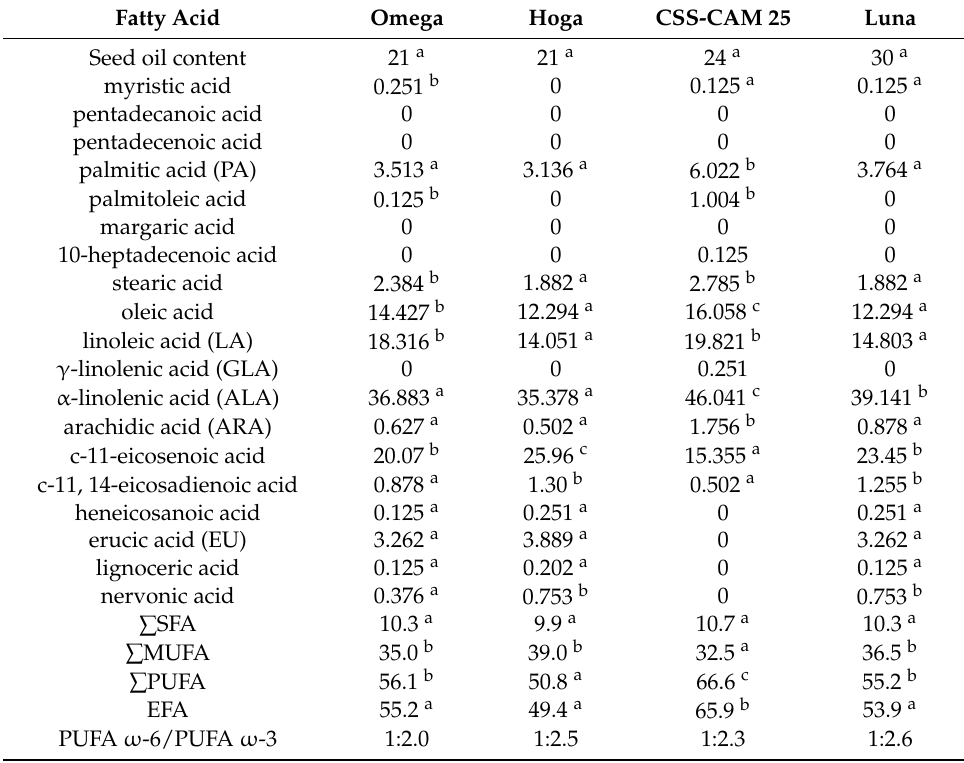
Table 4. The fatty acid composition (%) in spring and winter genotypes of Camelina sativa. Fatty